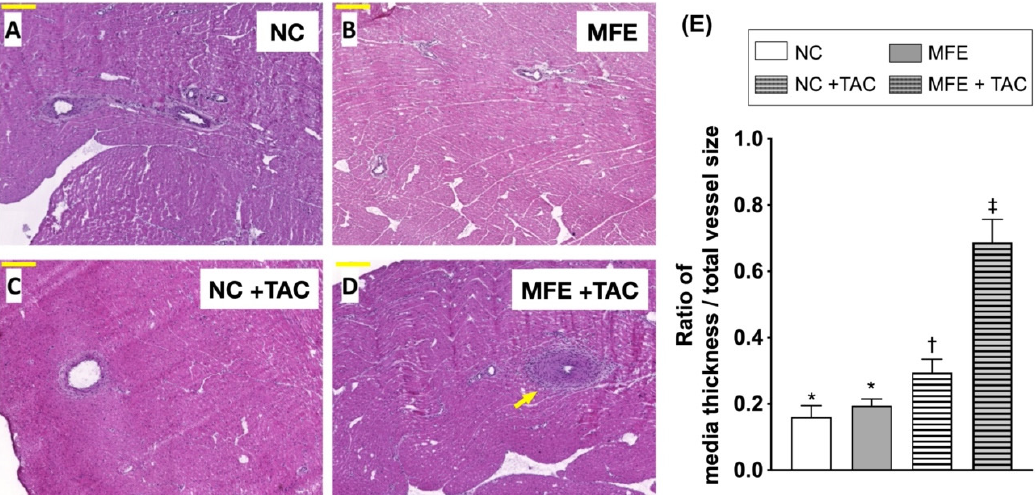
Figure 3. Histological quantification of myocardial arterial muscularization in offspring with maternal fructose exposure (MFE) and ventricular pressure overload induced by transverse aortic constriction (TAC) on sections with hematoxylin and eosin (H&E) staining. ( A ) Normal control rat offspring. ( B ) Rat offspring with MFE. ( C ) Normal control rat offspring with TAC. ( D ) Rat offspring with MFE and TAC. ( E ) Comparison of the degree of myocardial arterial muscularization in vessels with diameters > 100 µm among different treatment groups. The yellow arrow indicates myocardial arterial muscularization in offspring with MFE and TAC. NC, normal control. Groups with different symbols (*, †, ‡), p < 0.05. n = 8 for each group. Scale bar in left lower corner indicates 200 µm.